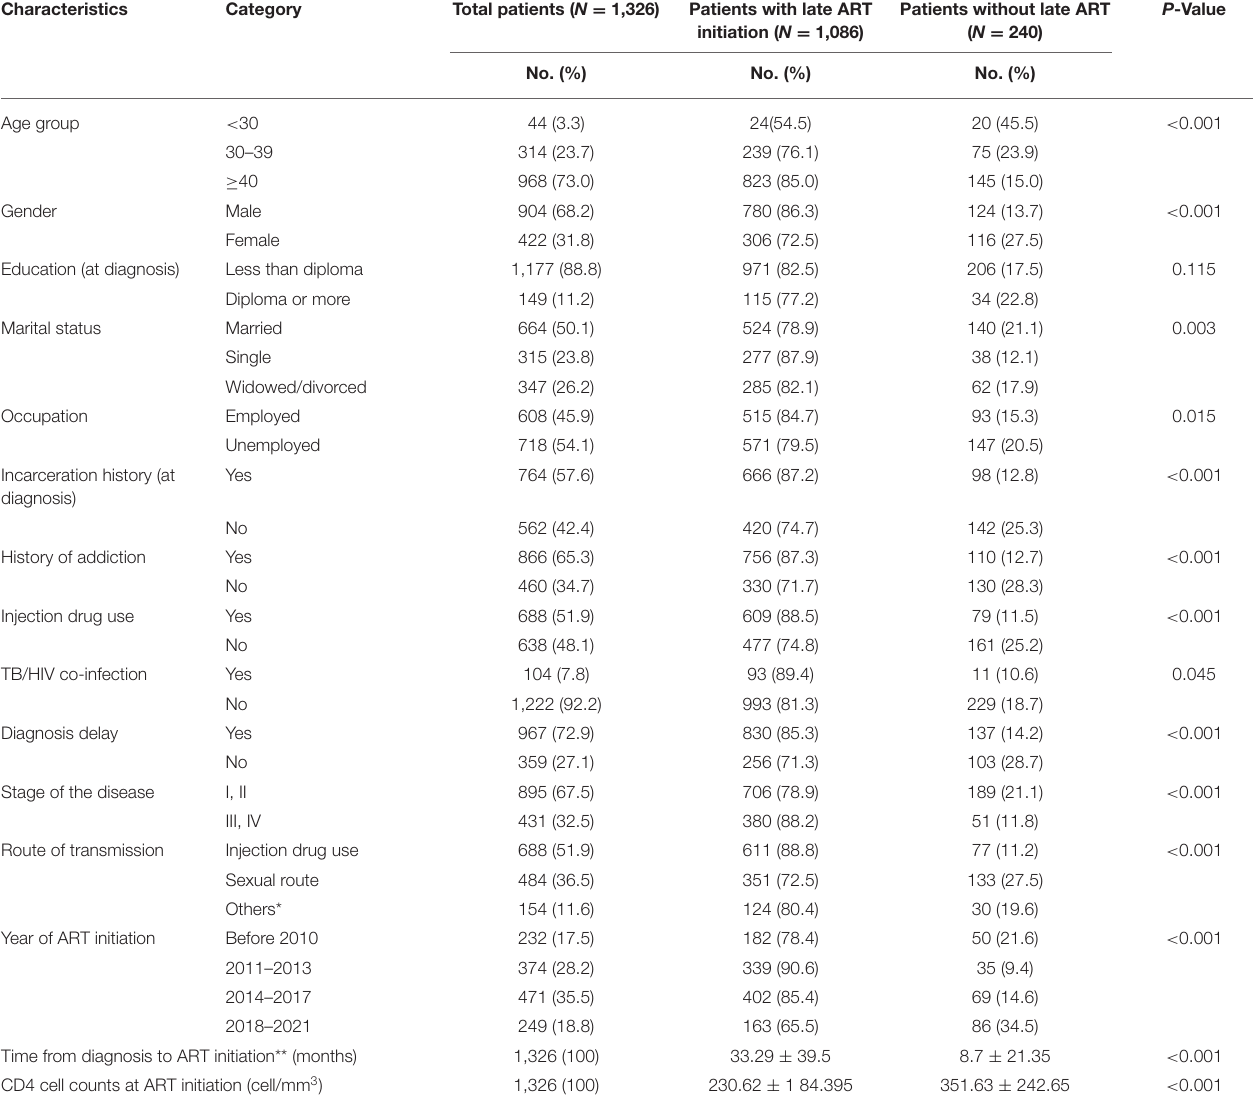
TABLE 1 | Analysis of the demographic and clinical data among early and late antiretroviral therapy (ART) initiation patients.